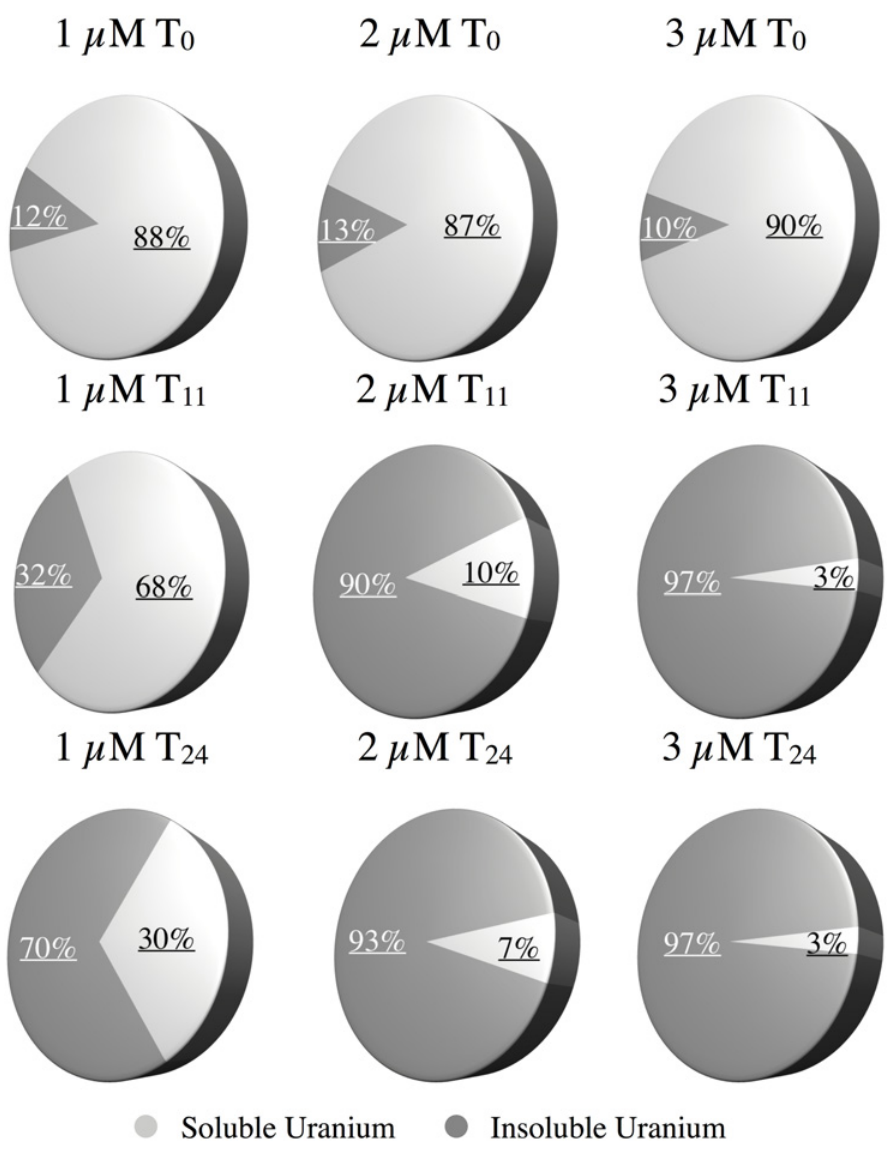
Fig 3. Average proportion of soluble and insoluble uranium over time with uranyl acetate addition (0 – 3 μ M) measured by ICP-mass spectrometry.